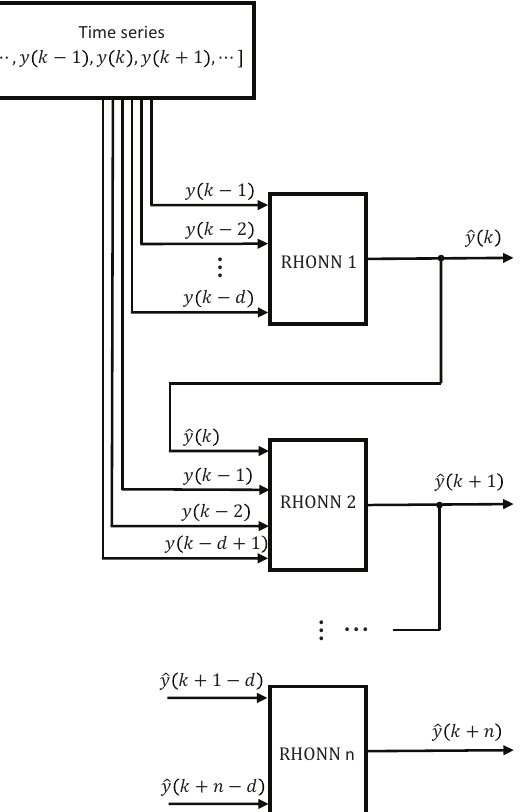
Figure 2. Proposed methodology for forecasting of time